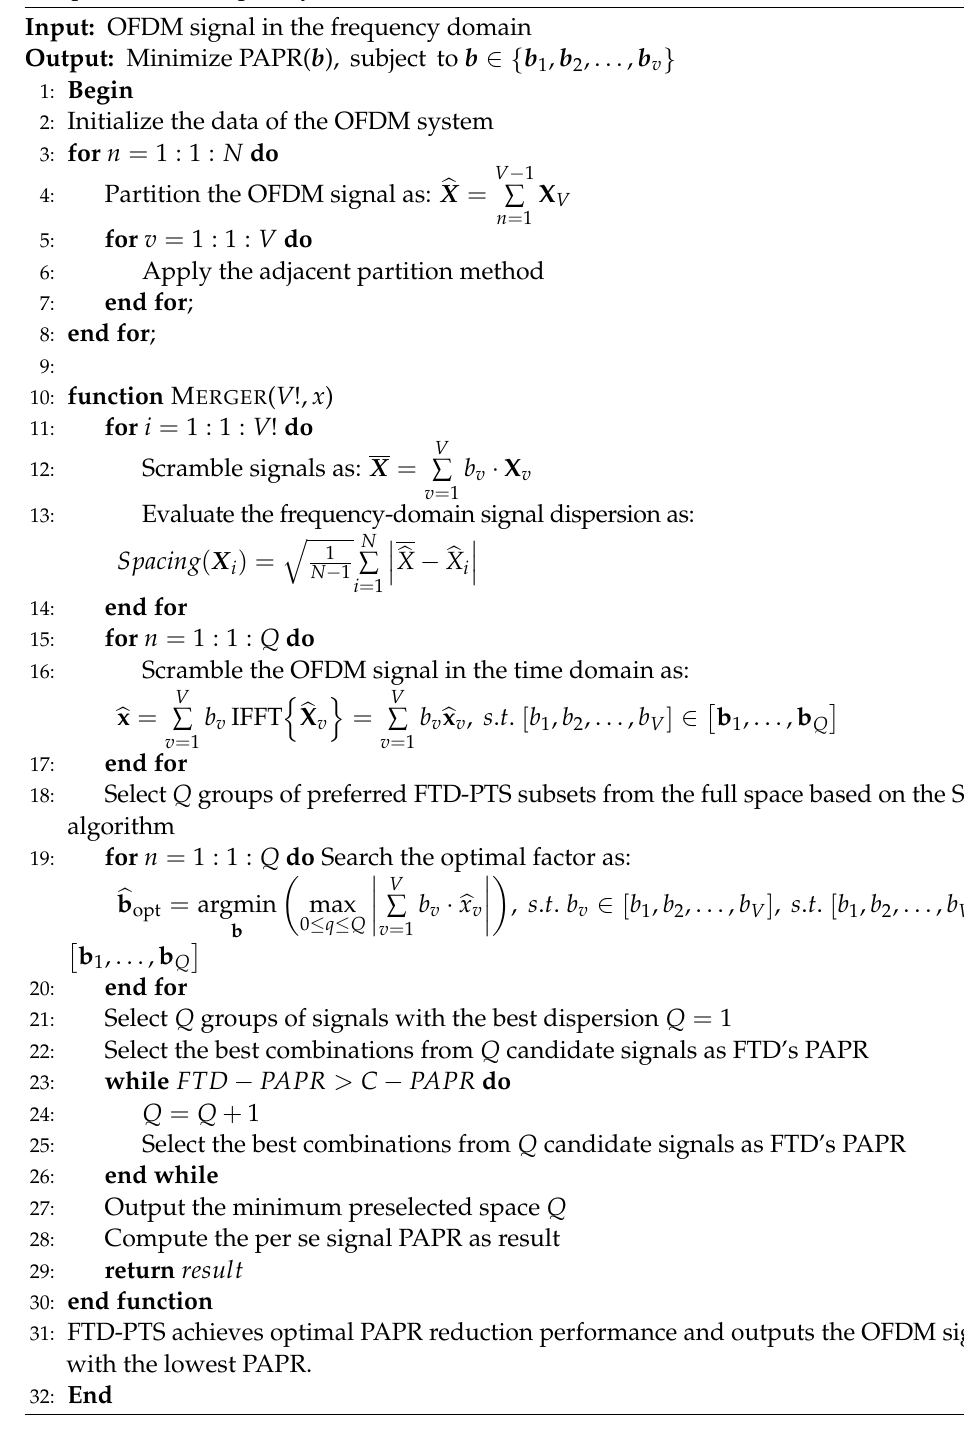
Algorithm 2 FTD-PTS obtains optimum PAPR reduction performance with regular computational